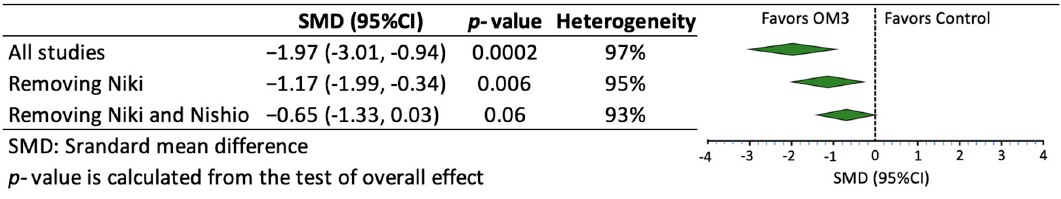
Figure 3. Sensitivity analysis after excluding the most and second most influential studies. In subgroup analysis, the e ff ect of OM3 on atherosclerosis di ff ered significantly by study location (Japan vs. other countries), site of atherosclerosis (coronary vs. carotid arteries), use of placebo (placebo-controlled trials vs. trials without placebo), presence of CHD (yes vs. no), statin use (yes vs. no), and source of OM3 (EPA vs. a combination of EPA and DHA). However, the subgroup analysis Nutrients 2019 , 11 , x FOR PEER REVIEW showed that the e ff ect was not significantly di ff erent by risk of bias (high vs. low) (Figure 4).